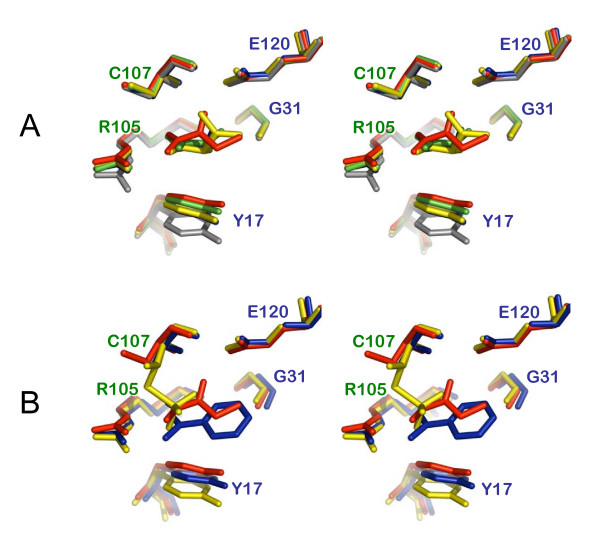
Comparisons of the TdcF ligand-binding pocket. Stereoviews depicting comparisons of the TdcF ligand-binding pocket. (A) shows a superposition of all the states displayed in Figures 3 and 4, where: grey = empty site; blue = ethylene glycol-bound (the ethylene glycol itself is mainly occluded by other ligands in this view); yellow = serine-bound; red = 2-ketobutyrate-bound; green = propionate-bound. (B) shows a superposition of the ligand-binding site from TdcF with 2-ketobutyrate bound in red, onto the site from hp14.5 with a benzoic acid molecule bound in blue (primary site only)(PDB accession code 1ONI), and the equivalent site in YjgF in yellow (PDB accession code 1QU9). In the latter, two conformers are seen for Cys-107, the major one being covalently modified and protruding into the ligand-binding pocket. Throughout, the view is identical to that seen in Figures 3 and 4. Figure generated using PyMOL [31].